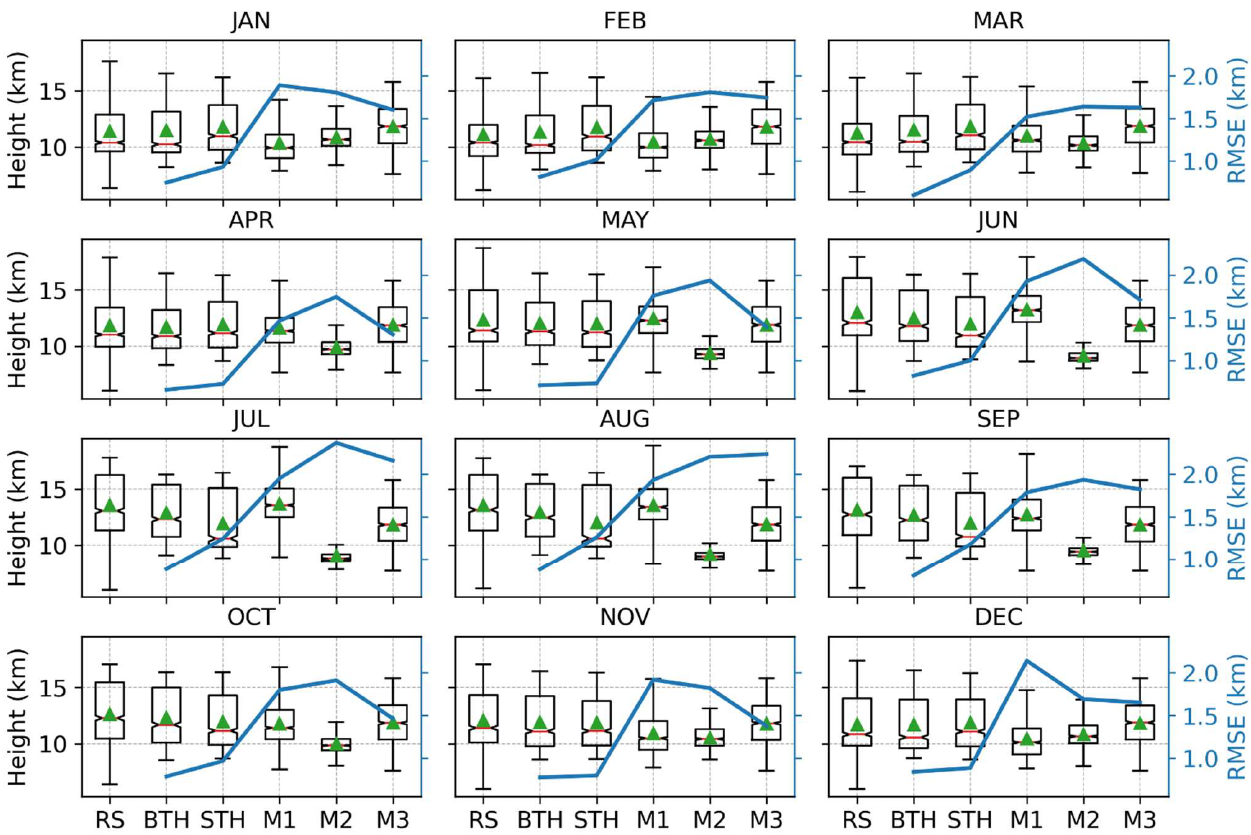
Figure 8. Boxplots for tropopause height determined from radiosondes (RS), the two models present in this study (STH and BTH), and three models (M1, M2, M3) developed by Mendes [47] for the three years of radiosonde data (2018–2020). The green triangle identifies the average and orange line the median, the blue line the RMSE (in km) obtained comparing radiosonde data with all the other models. Table 5. Main statistics for the entire period (determined against the radiosondes (RS) data).